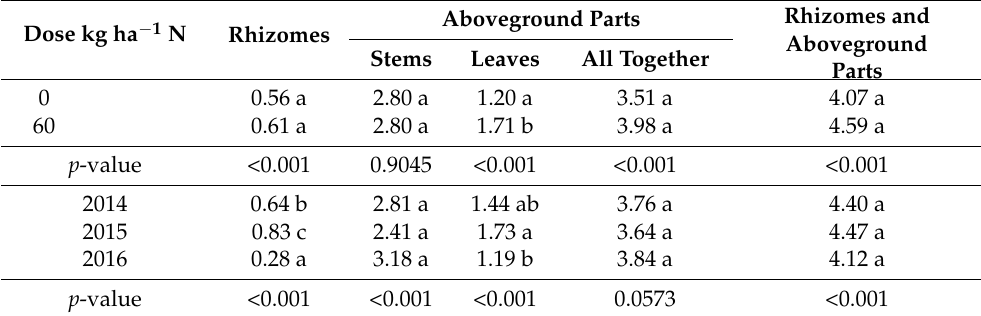
Table 6. Calcium uptake by the giant miscanthus in g · m − 2 (average for the years 2014–2016).